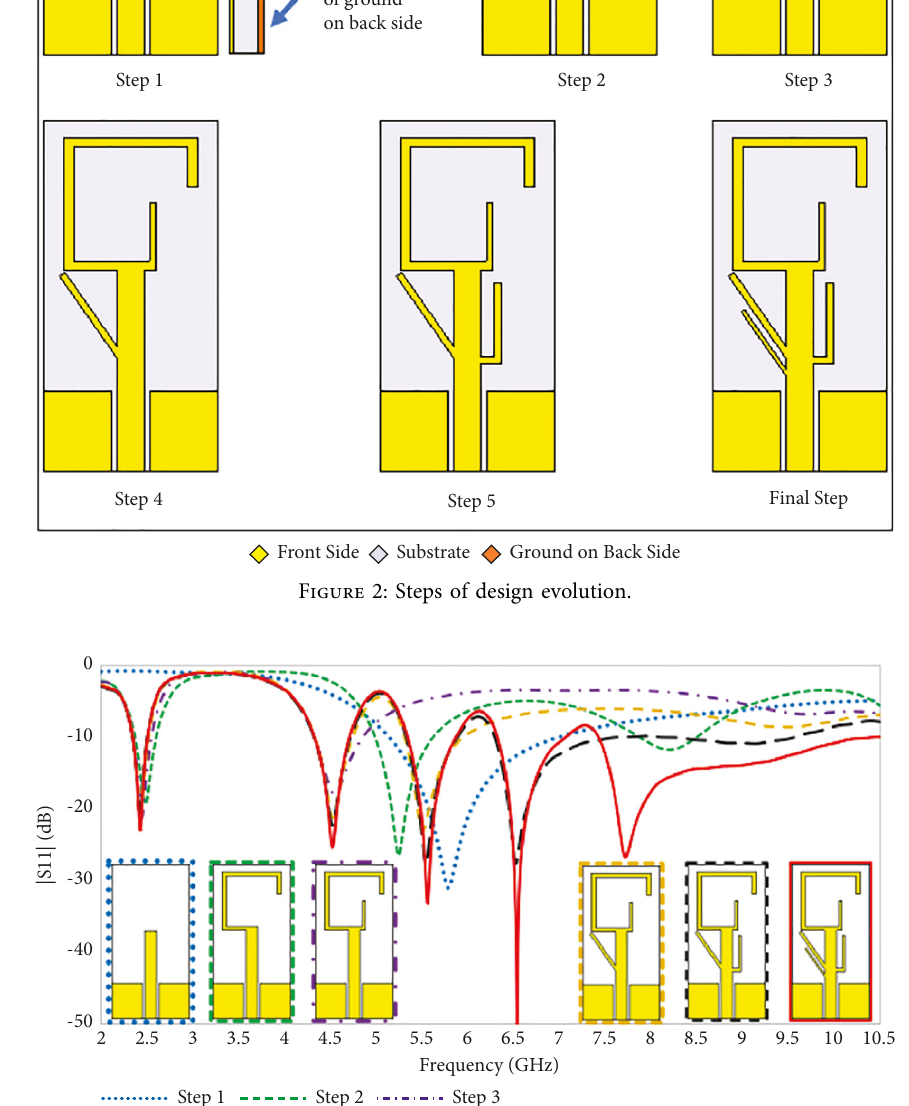
Figure 3: Reflection coefficients of various designs of the proposed